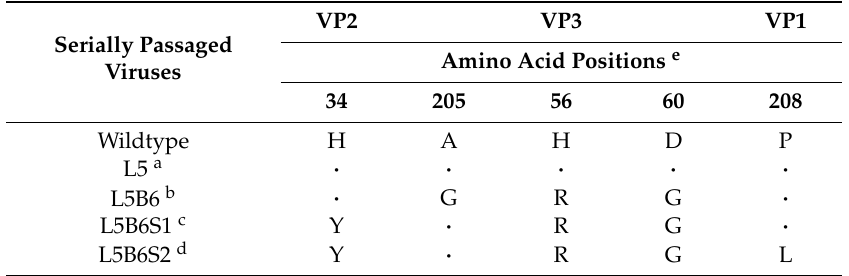
Table 1. Amino acid mutations of the P1 region of the O / SKR / Andong / 2010 virus following serial passaging.